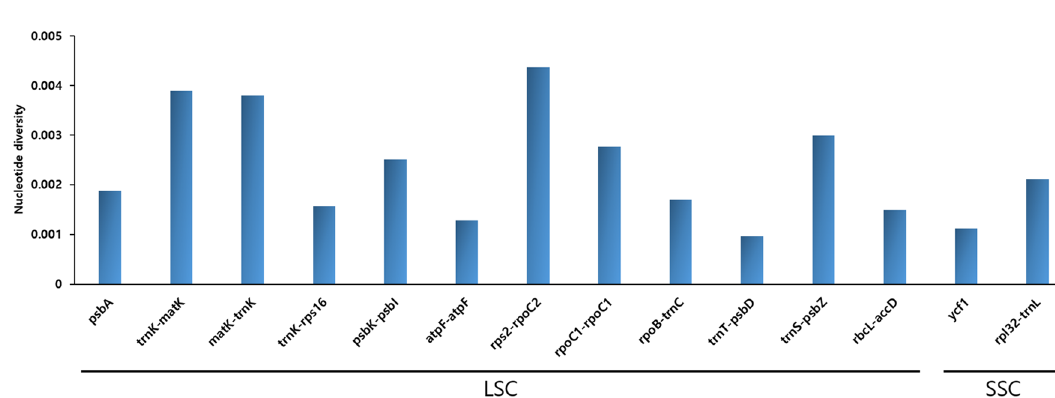
Figure 6. Comparison of nucleotide diversity (Pi) values among Iris ruthenica and I. uniflora species and parsimony haplotype analyses using psbA , matK-trnK , and psbK-psbl